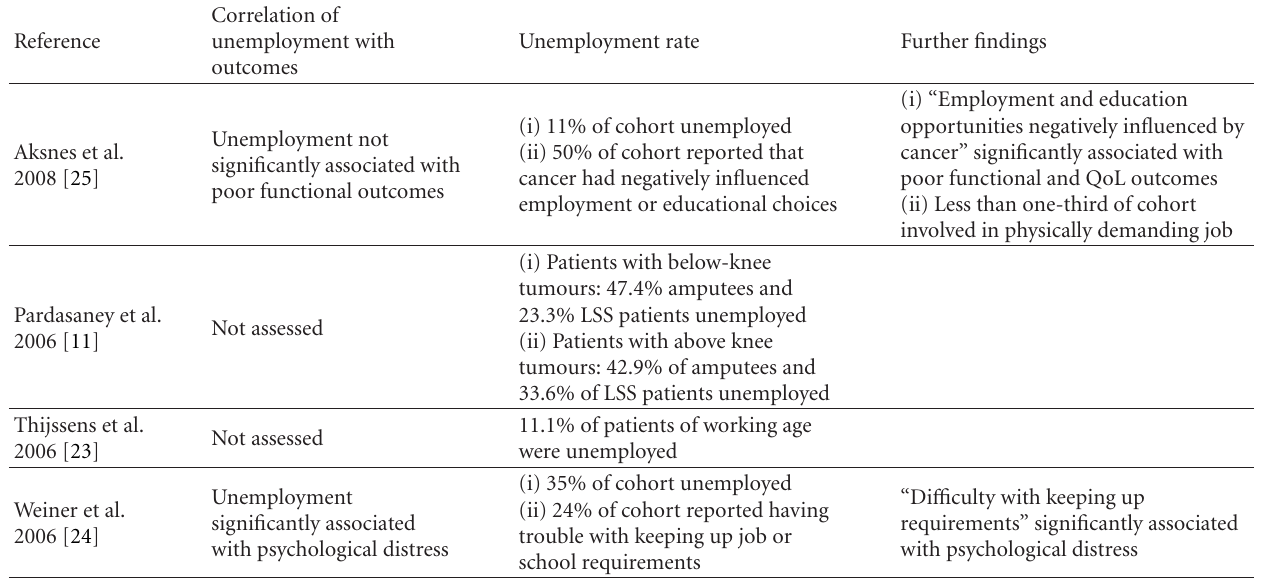
Table 6: Summary of employment characteristics.